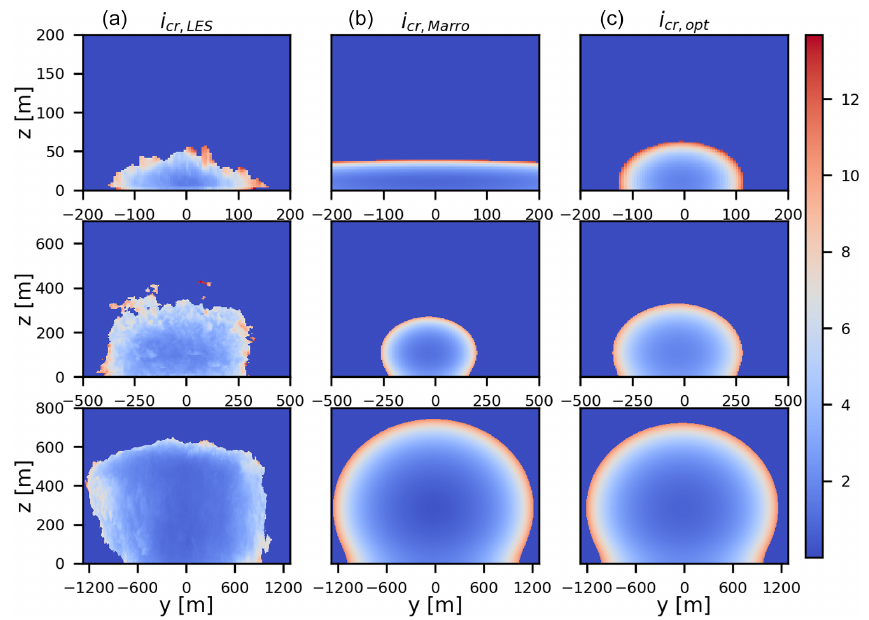
Figure 13. The y – z transect of the concentration fluctuation intensity in the relative coordinate system i cr calculated from the LES data. The other two columns show i cr calculated with Eq. (10) as found in the literature (b) and optimized for this case (c) .